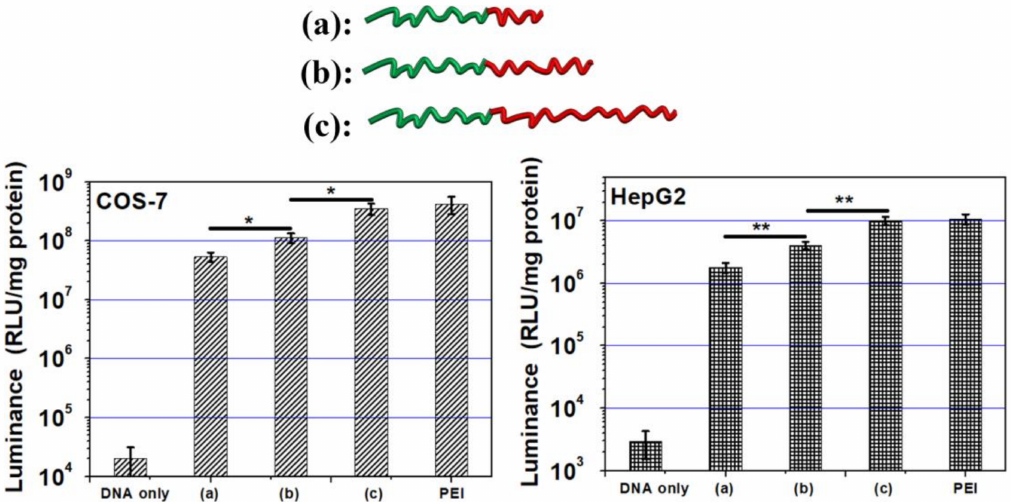
Figure 8. Gene transfection of ( a ) poly( L -lysine) 50 - block -poly( L -leucine) 10 , ( b ) poly( L -lysine) 50 - block - poly( L -leucine) 15 , ( c ) poly( L -lysine) 50 - block -poly( L -leucine) 25 at their optimized N/P ratio (N/P = 15) in different cell lines (Student’s t -test, * p < 0.05; ** p < 0.01) (mean ± SD, n =